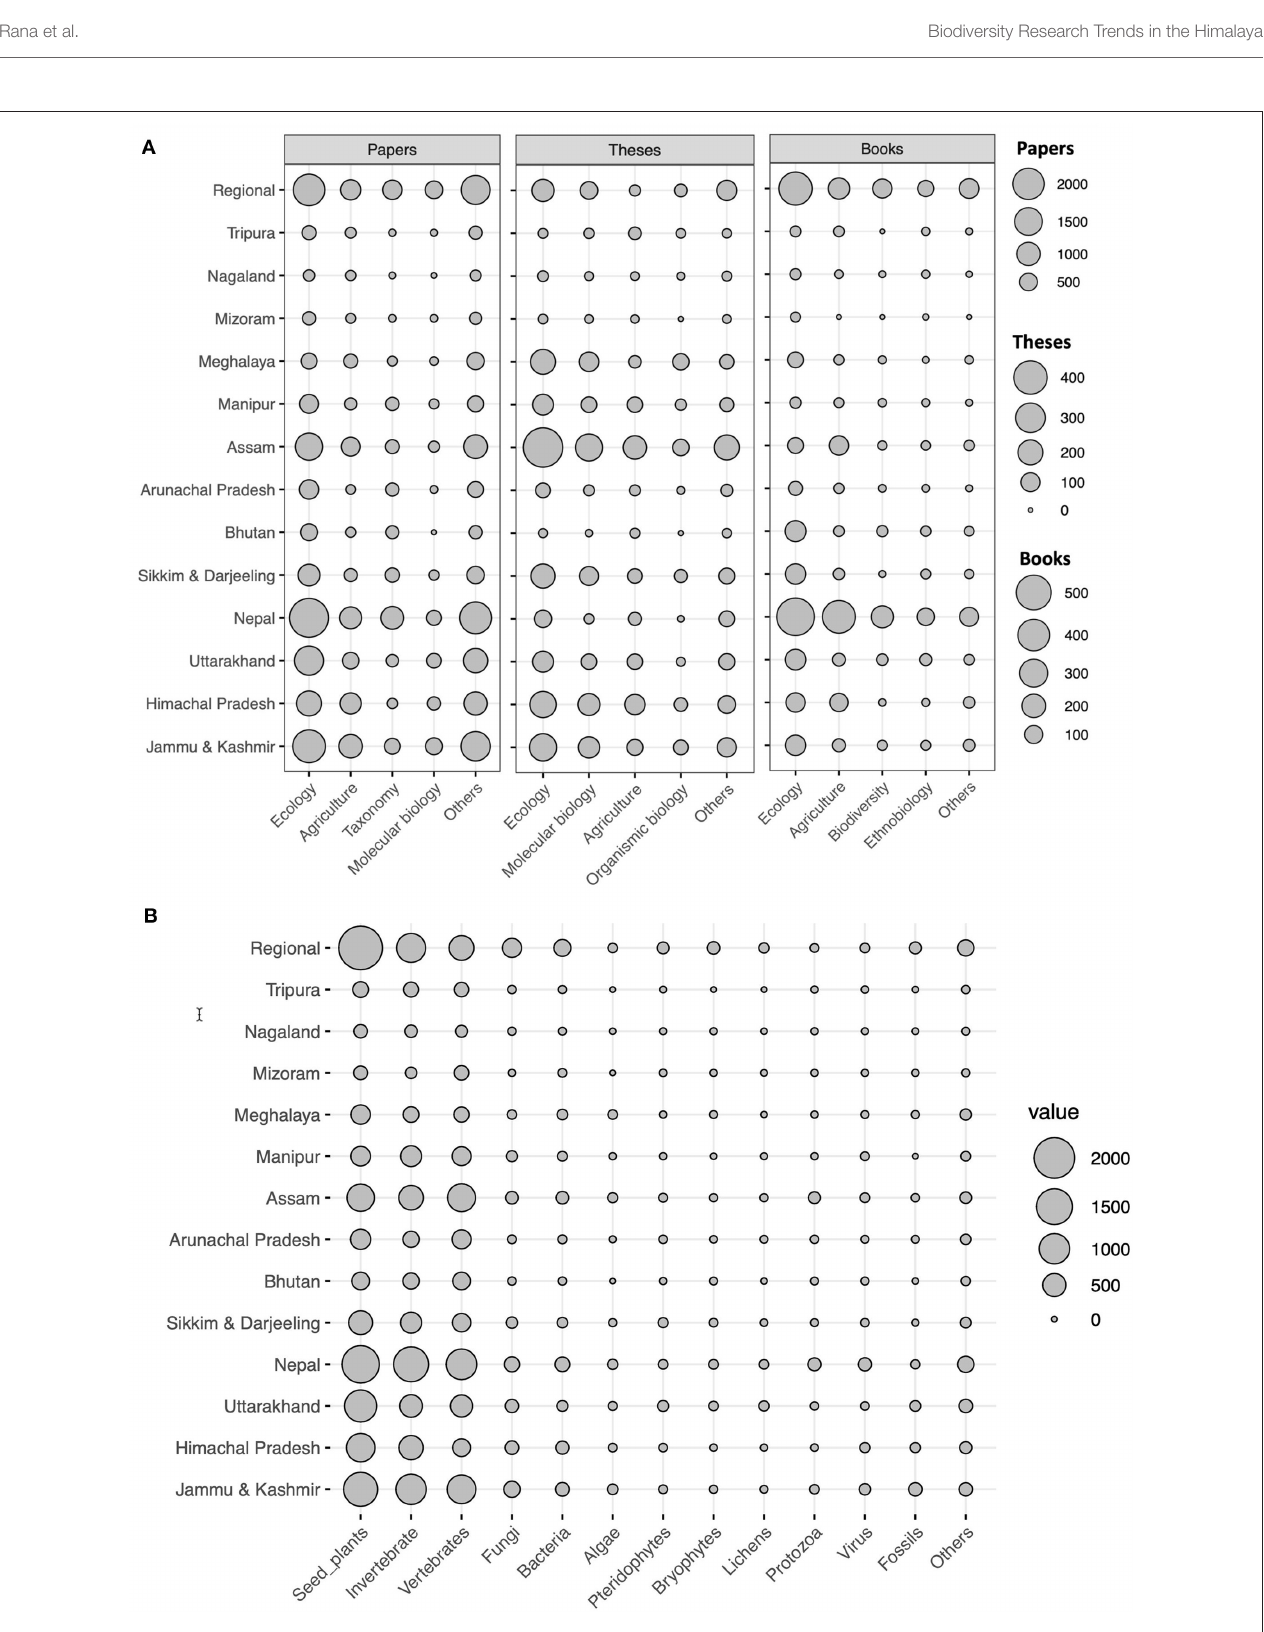
FIGURE 3 | Spatial distribution of the literature across the region for (A) published journal articles, theses, and books in major research disciplines and (B) taxonomic groups.